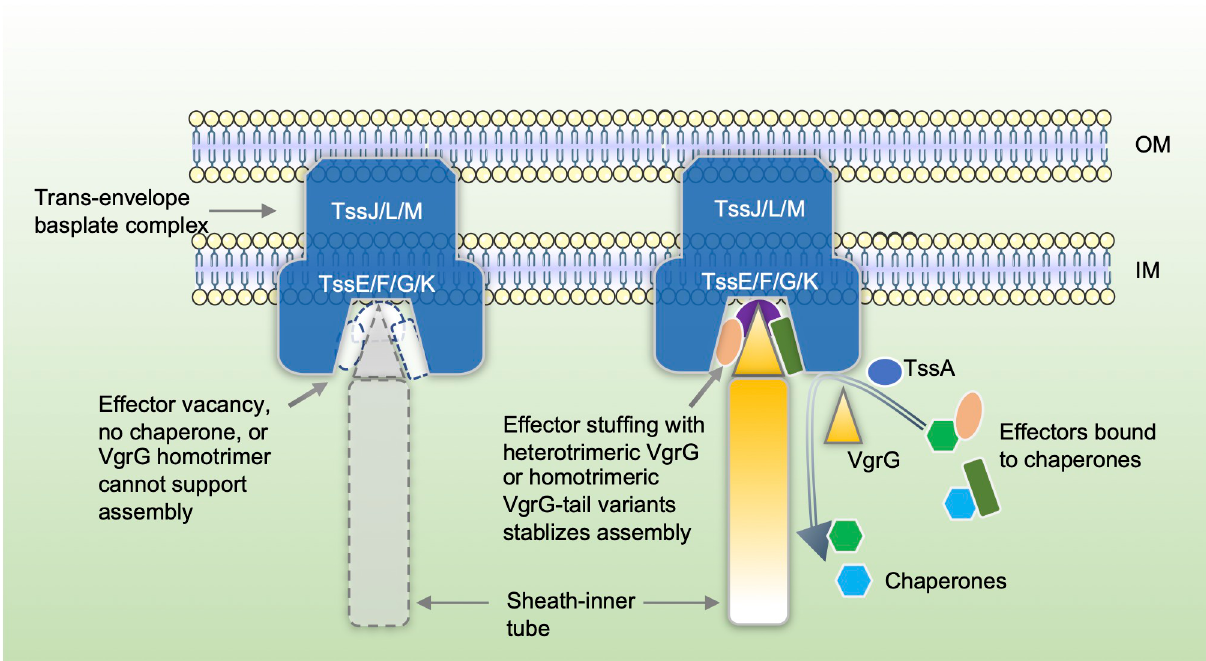
Fig 6. Effectors serve as structural components for T6SS assembly. Effector vacancy, chaperone deletion, or VgrG homotrimer cannot support T6SS assembly. The assembly of T6SS in A . dhakensis requires multiple effectors bound to a heterotrimeric VgrG spike or a homotrimer of VgrG hybrids with varied C-terminal tails, as well as sufficient effector-baseplate interaction. The process involves effector-chaperone interaction for stabilizing and delivering effectors to the VgrG spike, as well as direct interaction between effector and structural proteins. Therefore, the VgrG-dependent effectors might be considered integral parts of the